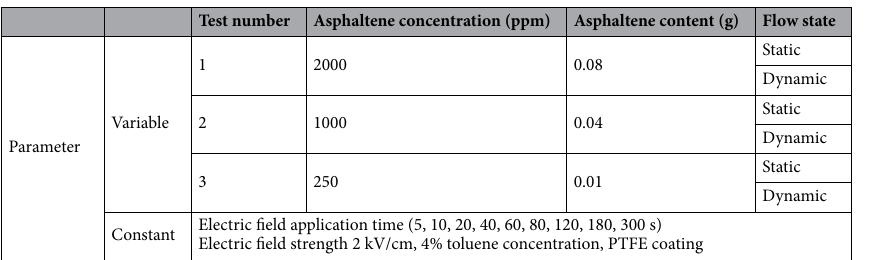
Table 6. The design of experiments to investigate the effect of concentration on the amount of asphaltene